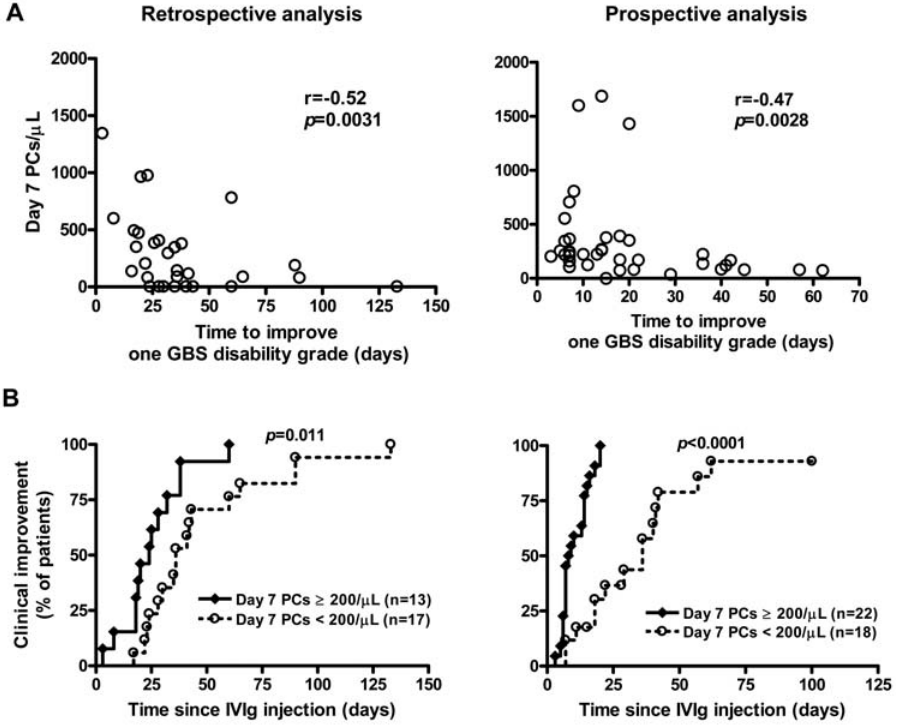
Figure 5. Correlation between the number of plasma cells and clinical improvement in retrospective (n=30, left panels) and prospective (n=40, right panels) studies. (A) Strong negative correlation in both studies between the absolute number of IVIg-mobilized plasma cells (PCs) and time to improve one GBS disability-grade. Correlation was analyzed using Spearman test. (B) Day 7 plasmacytosis correlates with faster clinical improvement. Kaplan-Meier analysis of time to one disability-grade improvement following IVIg in relation to day 7 plasma cell counts enumerated on a routine hematology analyzer and confirmed by blood smear exam.